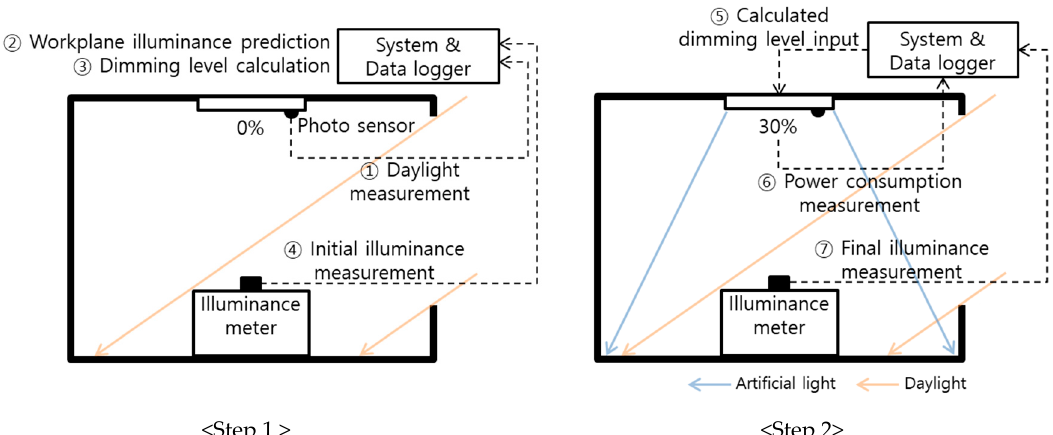
Figure 12. Process of evaluating the target illuminance accuracy, daylight illuminance on workplane prediction accuracy, and energy savings.